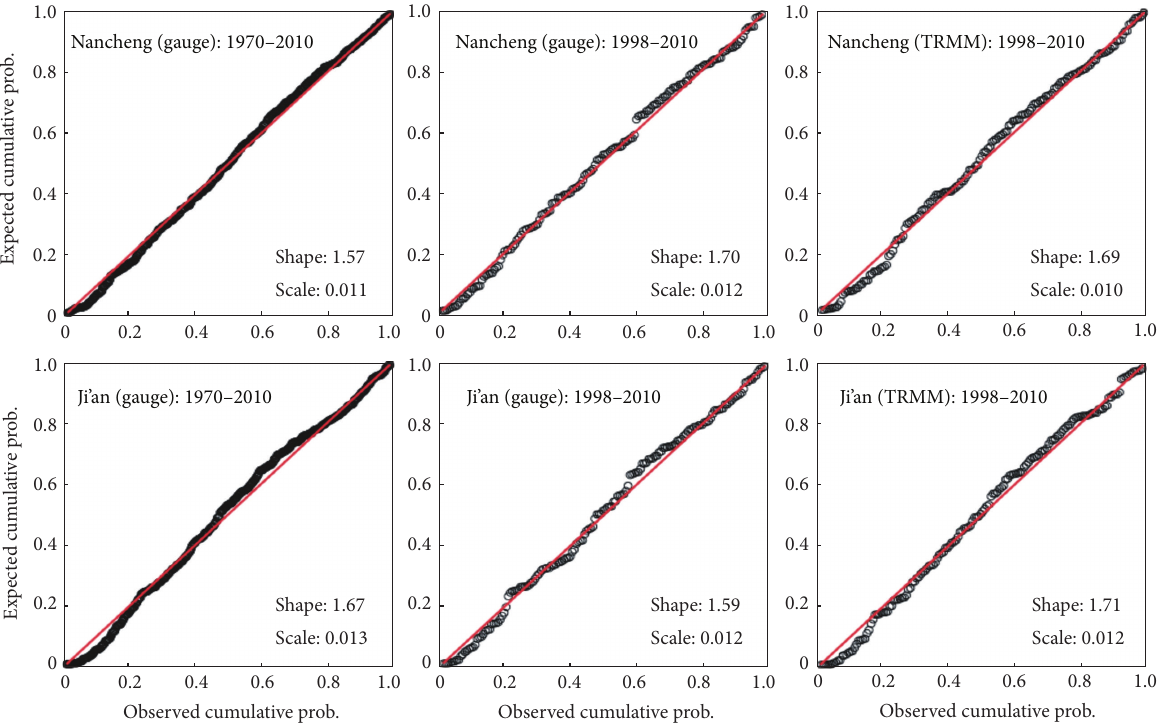
Figure 3: Comparison of Gamma P-P plots for the long and short period data at Nancheng and Ji’an station.